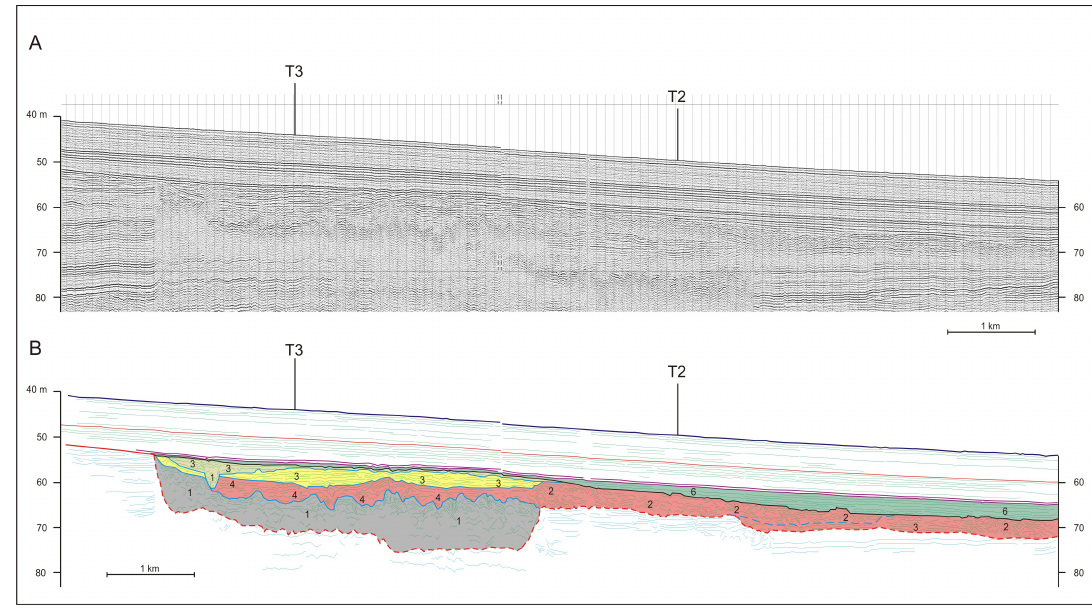
Figure 10. Part of seismic profile P5. Seismic section ( A ) and interpretation ( B ) showing the transversal profile of the Ofanto valley (OV) with thick basal infilling by unit BU1 l and subunit B2 m , which shows a change of seismic facies 2 outside the OV to seismic facies 4 in the OV, with evident channel